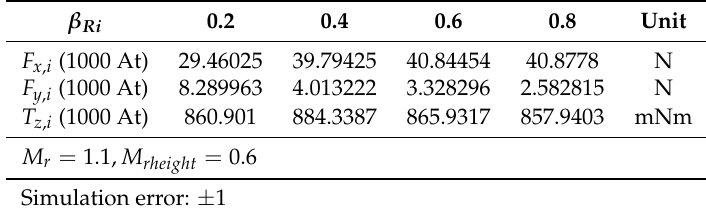
Table 12. Simulation results for different values of β Ri .